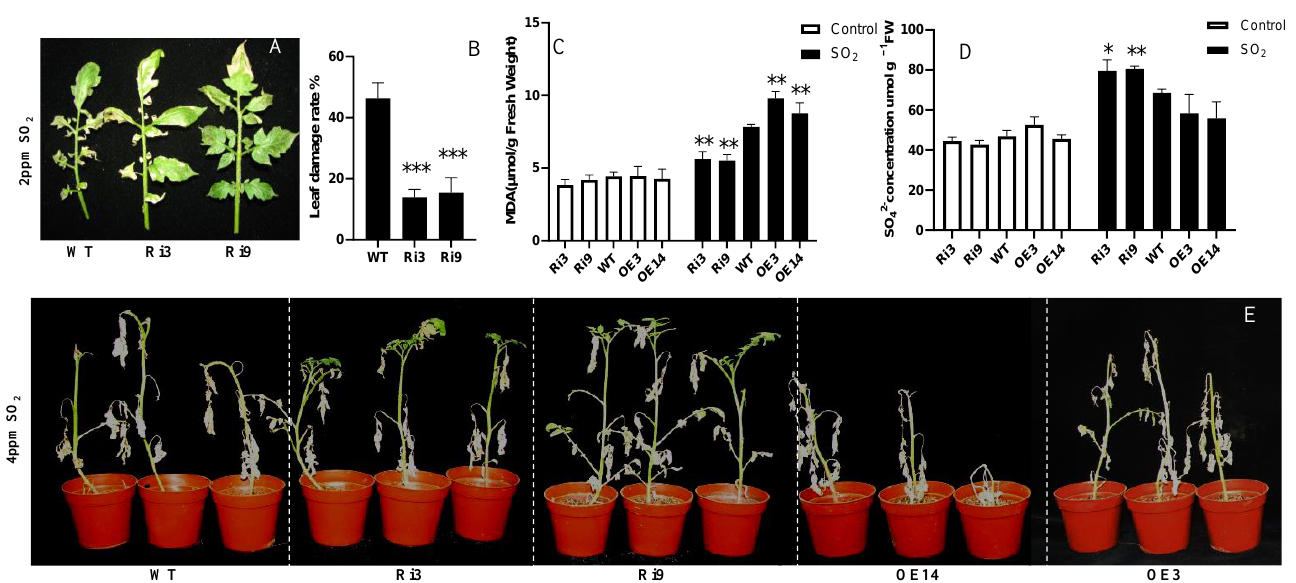
Figure 7. Responses of the HyPRP1 RNA interference lines (Ri), overexpression lines (OE) and wild-type (WT) plants to SO 2 toxicity at different concentrations. ( A ) Leaves of treated WT and Ri plants which recovered 4 d after SO 2 exposure at 2 ppm for 2 h. ( B ) Effect of SO 2 on Ri and WT plants which recovered 4 d after exposure as ( A ) measured by leaf damage area (%) (The percentage of damaged leaf area in whole leaf area, sampled at the fourth and fifth leaves from the top of the plant). Values are means ± SE ( n = 12). ( C ) MDA concentration in 2 ppm SO 2 -treated for 2 h and untreated (Control) leaves from Ri, overexpressed, and WT plants. Values are means ± SE ( n = 3). ( D ) Sulfate concentration in 2 ppm SO 2 -treated for 2 h and untreated (Control) leaves from Ri, overexpressed, and WT plants. Values are means ± SE ( n = 3). ( E ) The growth of HyPRP RNAi (Ri) and wild-type (WT) plants which recovered 7 d post-exposure to 4 ppm SO 2 for 4 h. The difference between OE or Ri compared to WT indicated * p < 0.05, ** p < 0.01, *** p < 0.001.